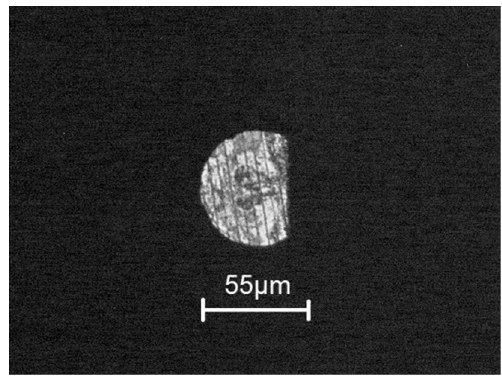
Figure 16. Front view of cut-side shaped micro-tool.